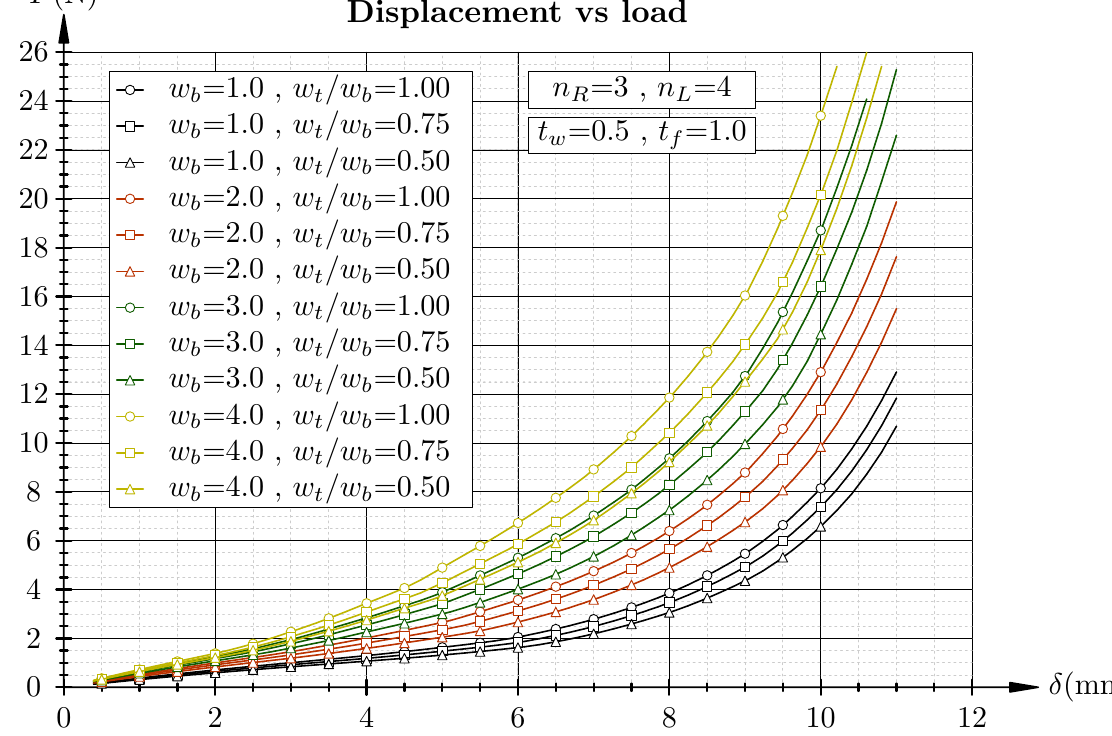
Figure 11. Variation of the fiber bottom width within the